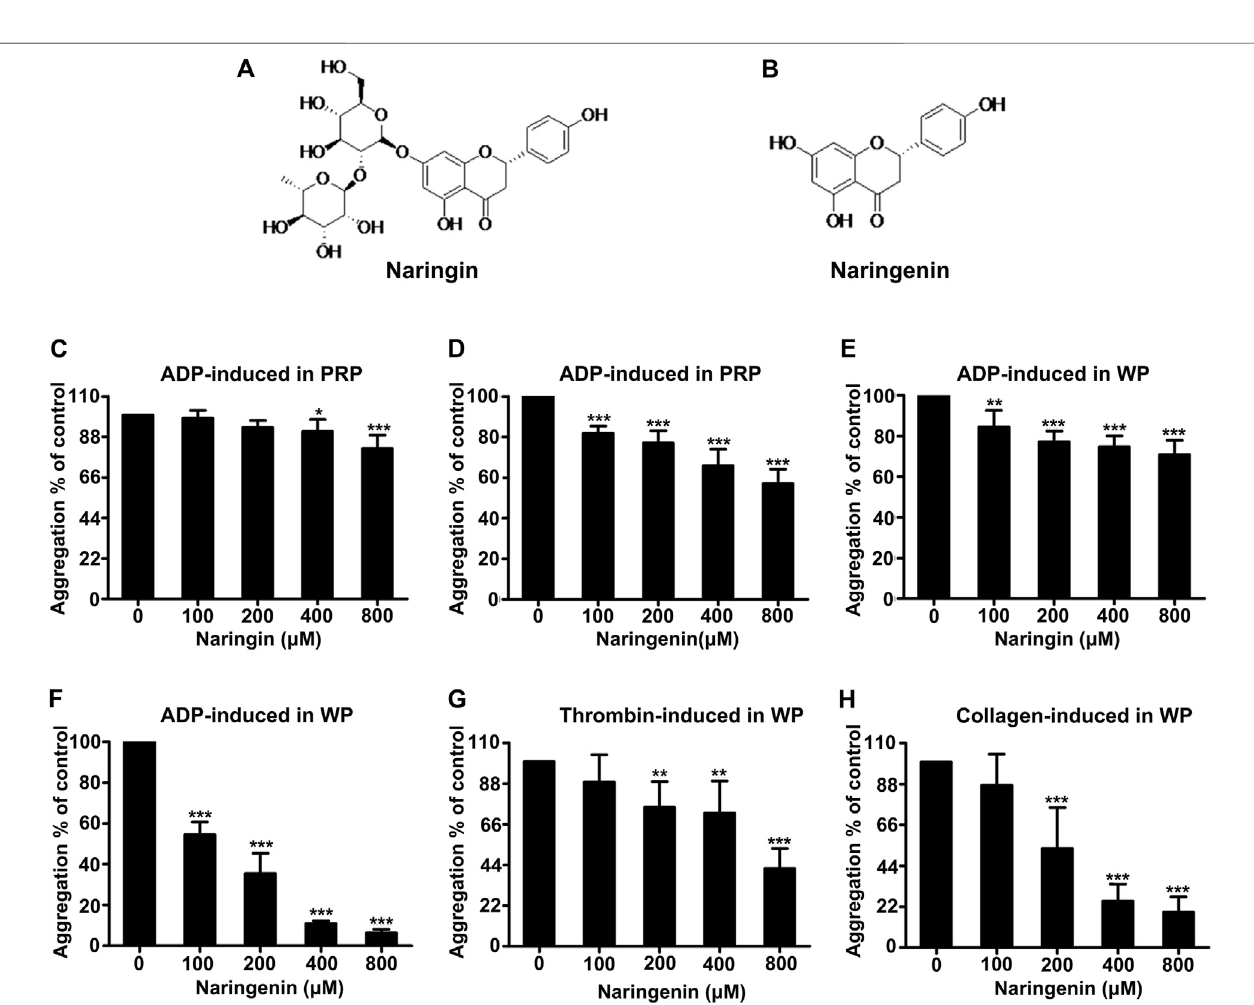
FIGURE1| Effectsofnaringeninandnaringinonplateletaggregation.Chemicalstructureofnaringin (A) andnaringenin (B) .Theeffectsofnaringin (C) ornaringenin (D) onPRPweremeasuredfollowingstimulationwith10 μ mol/LADP.Ratwashedplateletaggregationperformedwithorwithoutdifferentconcentrationsofnaringin (E) or naringenin (F) was recorded after stimulation with 10 μ mol/L ADP. Similarly, Washed platelet aggregation performed with vehicle or various concentrations of naringeninwasrecordedafterstimulationwith0.2 U/mLthrombin (G) or2 μ g/mlcollagen (H) .WPrepresentswashedplatelets.Dataareexpressedasmeans ± SD ( n (cid:2) 6), the level of aggregation obtained at 5 min with vehicle-treated samples (0 μ M) was taken as 100%. * p < 0.05, ** p < 0.01, *** p < 0.001 compared with the vehicle control group.